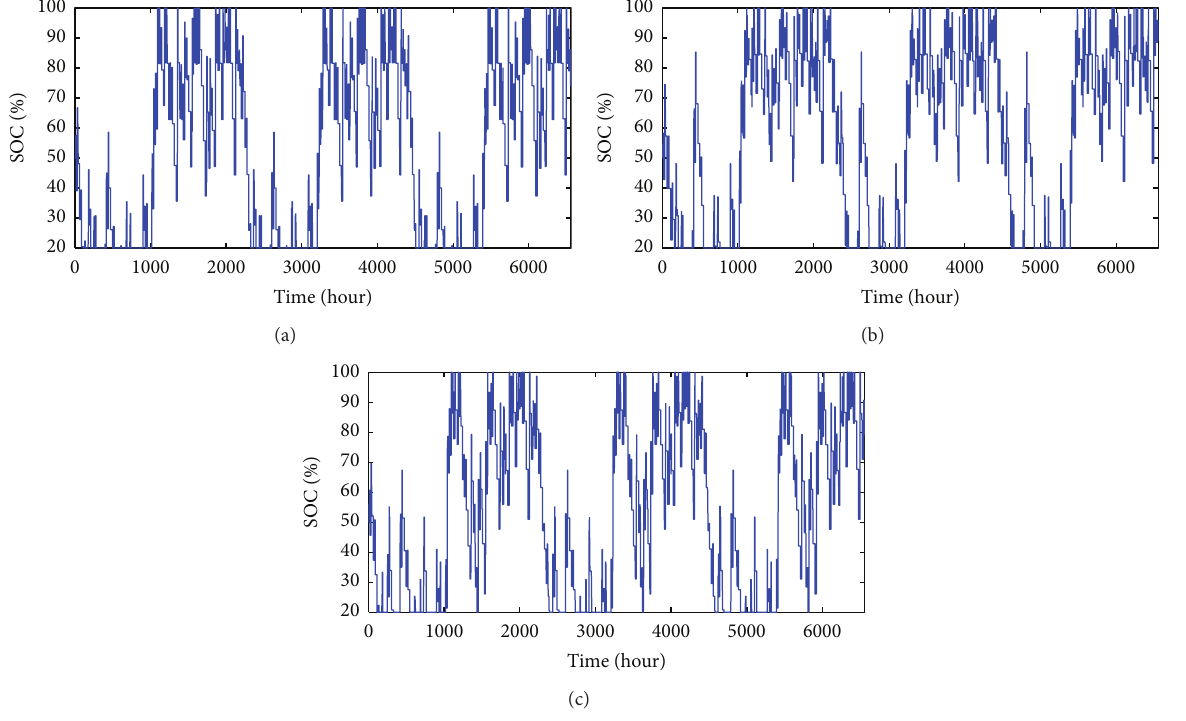
Figure 9: SOC for optimal BESS size obtained with (a) EOFA, (b) FA, and (c)